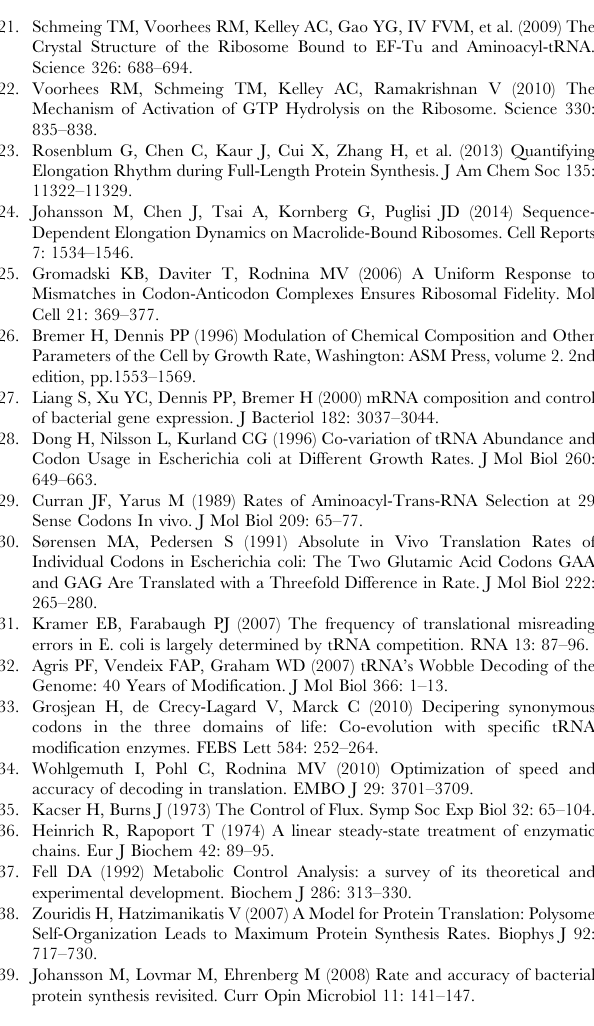
Figure S3 Codon-specific elongation rates in vitro and in vivo . Codon-specific elongation rates v c ,elo in units of amino acids per second as calculated from Eq. 17, see Methods section in the main text, using the decomposition of the codon-specific elongation times in Eq. 7 and the complete sets of individual transition rates: (A) In-vitro values v c ,elo for the high-fidelity buffer at 37 u C, obtained from the individual rates in Table 1; (B, C) In- for E. coli at growth conditions of (B) 0.7 dbl/h vivo values v ? c ,elo and (C) 2.5 dbl/h, calculated from the individual rates in Table 2.